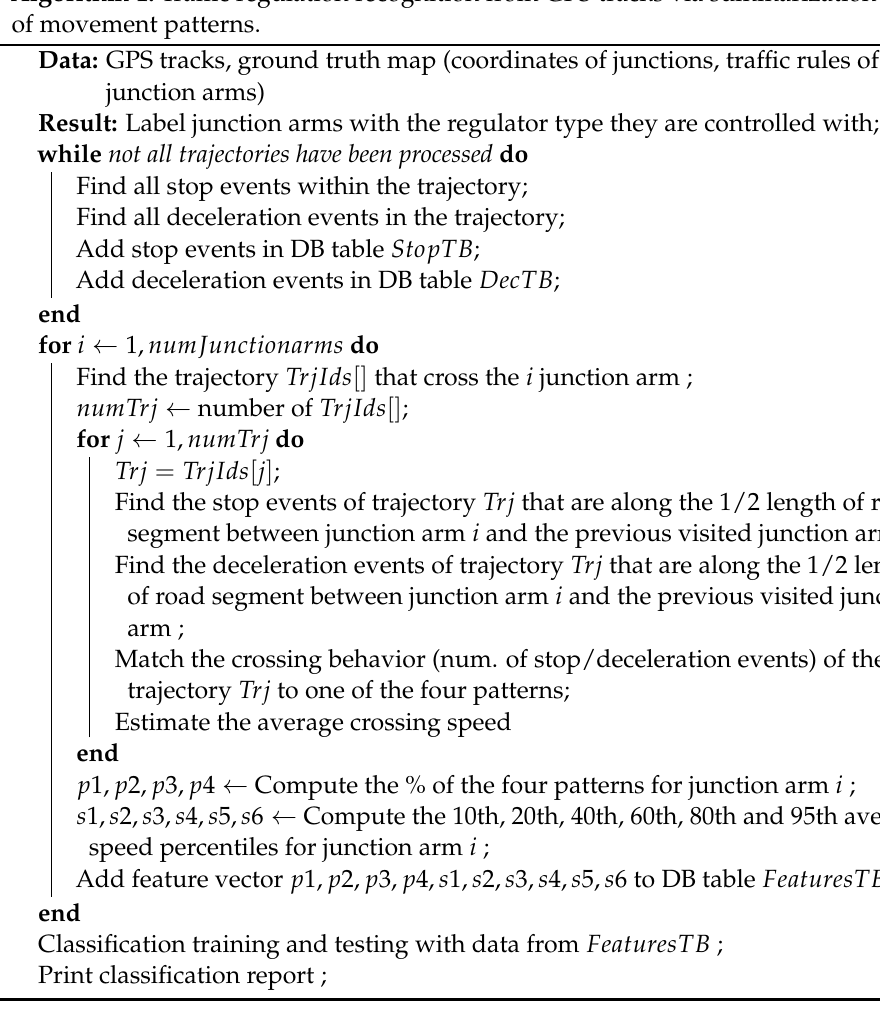
Algorithm 1: Traffic regulation recognition from GPS tracks via summarization of movement